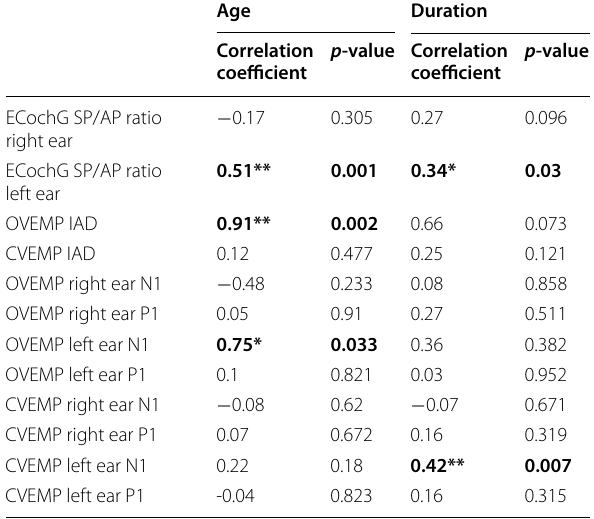
Table 17 Correlations between age, duration of the disease, and all test